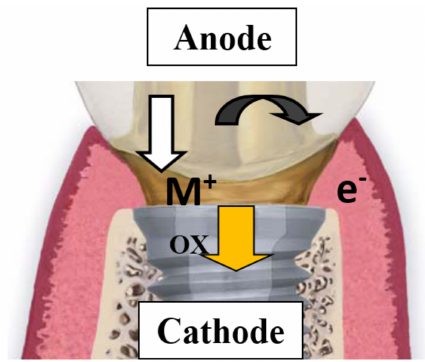
Figure 1. Galvanic couple formed in implants: the more active metal (less noble) acts as the anode releasing metal ions to the medium, while the less active metal (more noble) acts as the